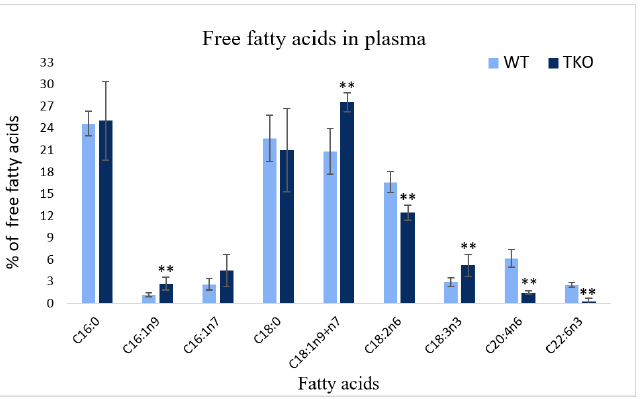
Figure 3. Comparison of free (non-esterified) fatty acids (FFA) in the plasma from wild-type (WT) and triple-synuclein knockout mice (% of total FFA). Values represent means ± s.d. ( n = 6). ** p < 0.01.